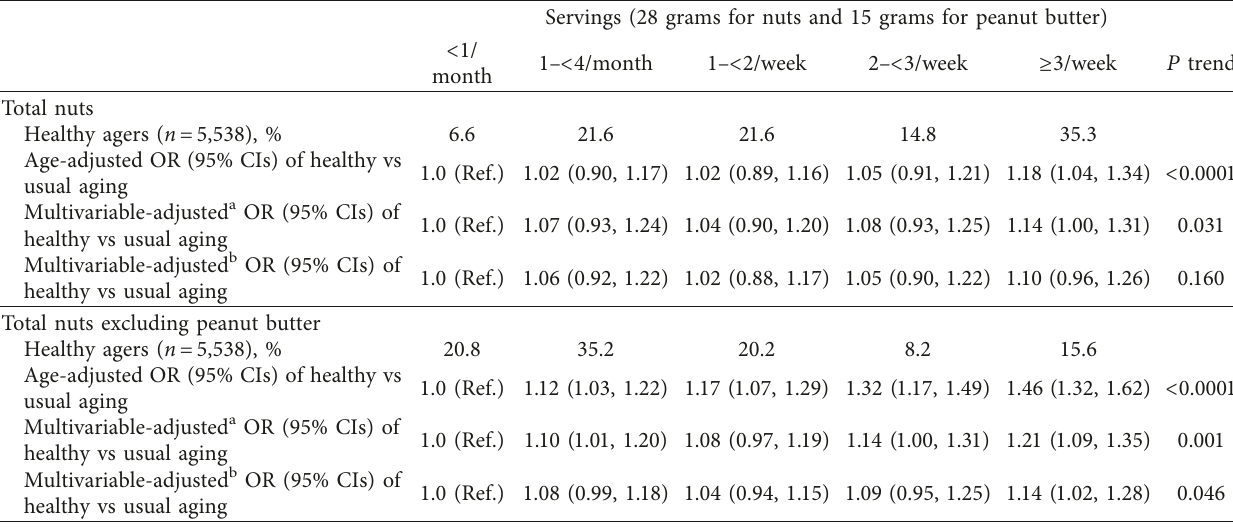
Table 2: Odds of healthy aging, according to frequency of total consumption of nuts at midlife in the Nurses’ Health